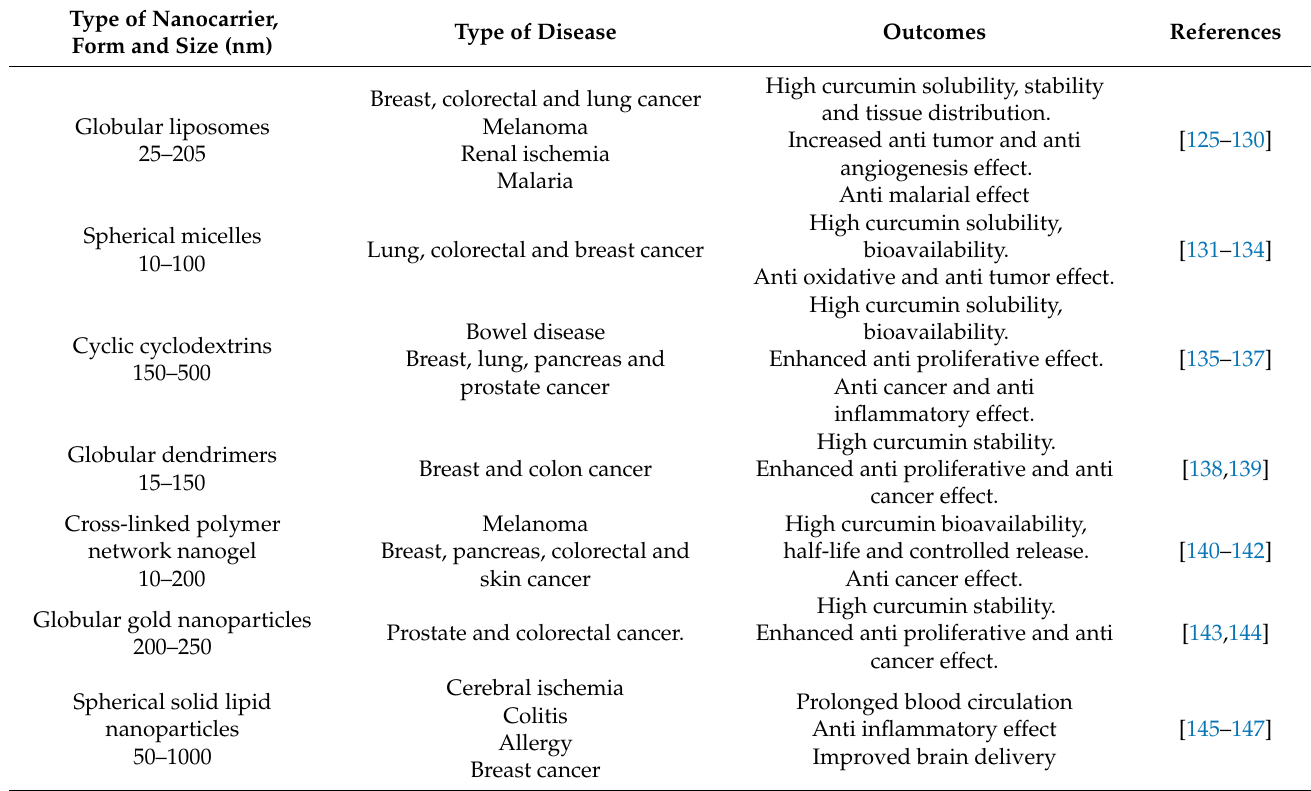
Table 6. Summary of some types of nano encapsulation of